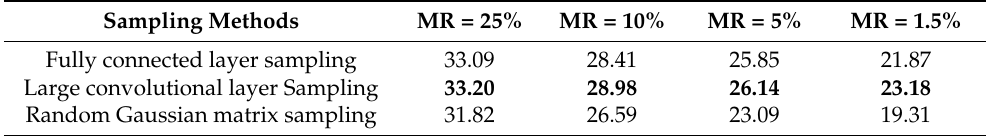
Table 1. Test set performance comparison in terms of the average PSNR (dB) under different MR with different sampling methods. The best performance is marked in bold. Sampling